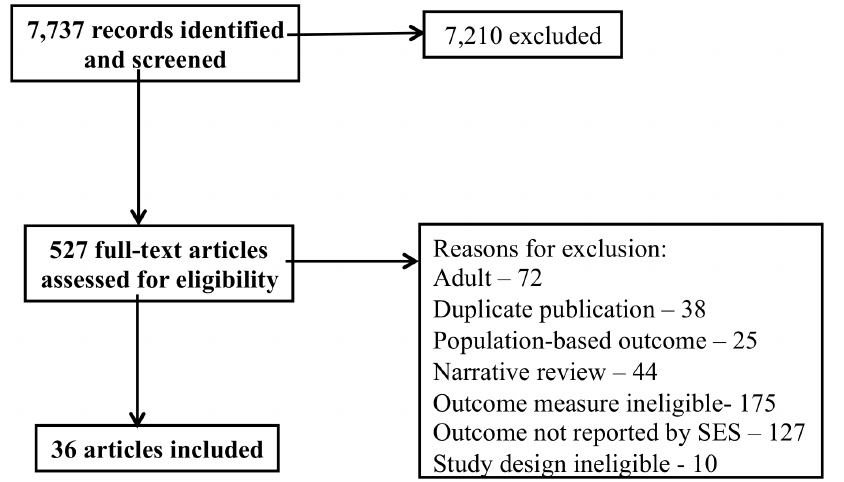
Figure 1. PRISMA flow diagram. doi:10.1371/journal.pone.0089482.g001 PLOS ONE |